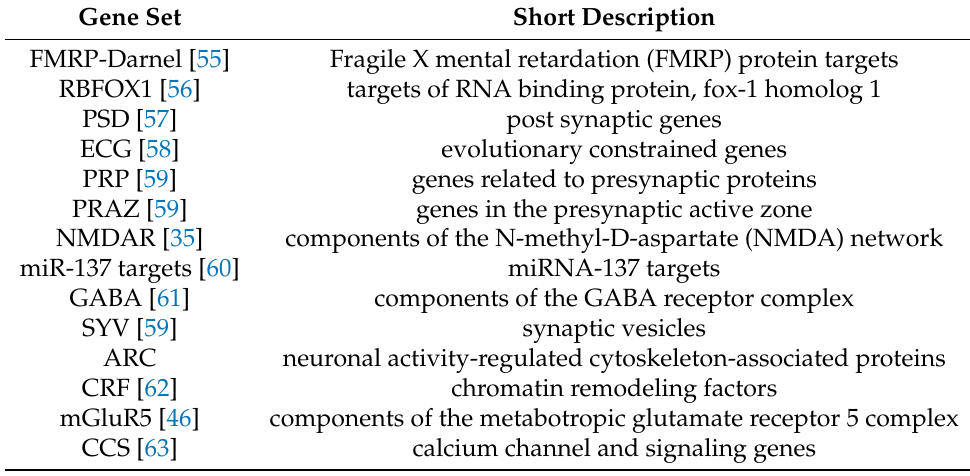
Table A1. Gene sets implicated in